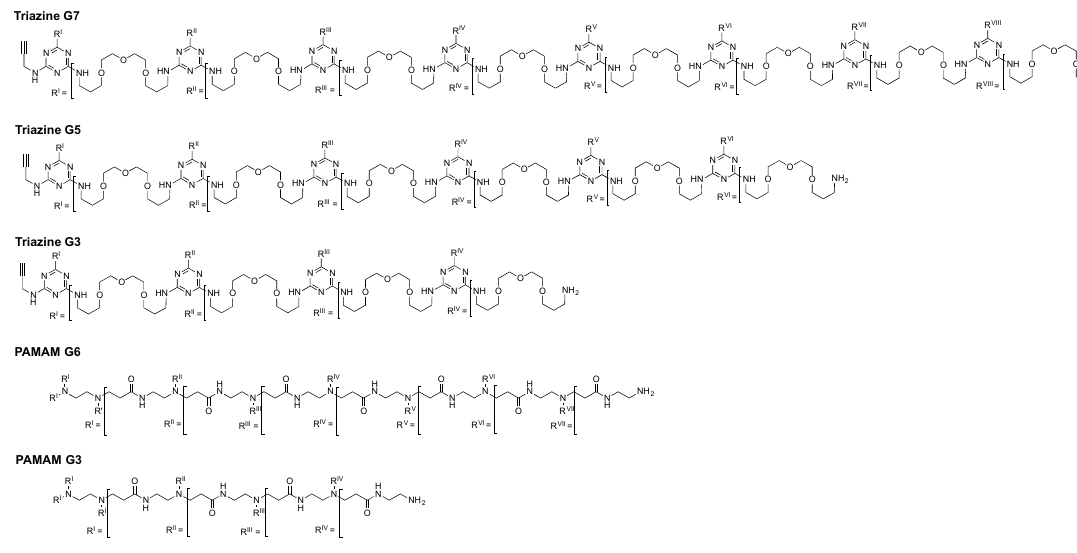
Chart 1. Structures of the triazine and PAMAM dendrimers examined.